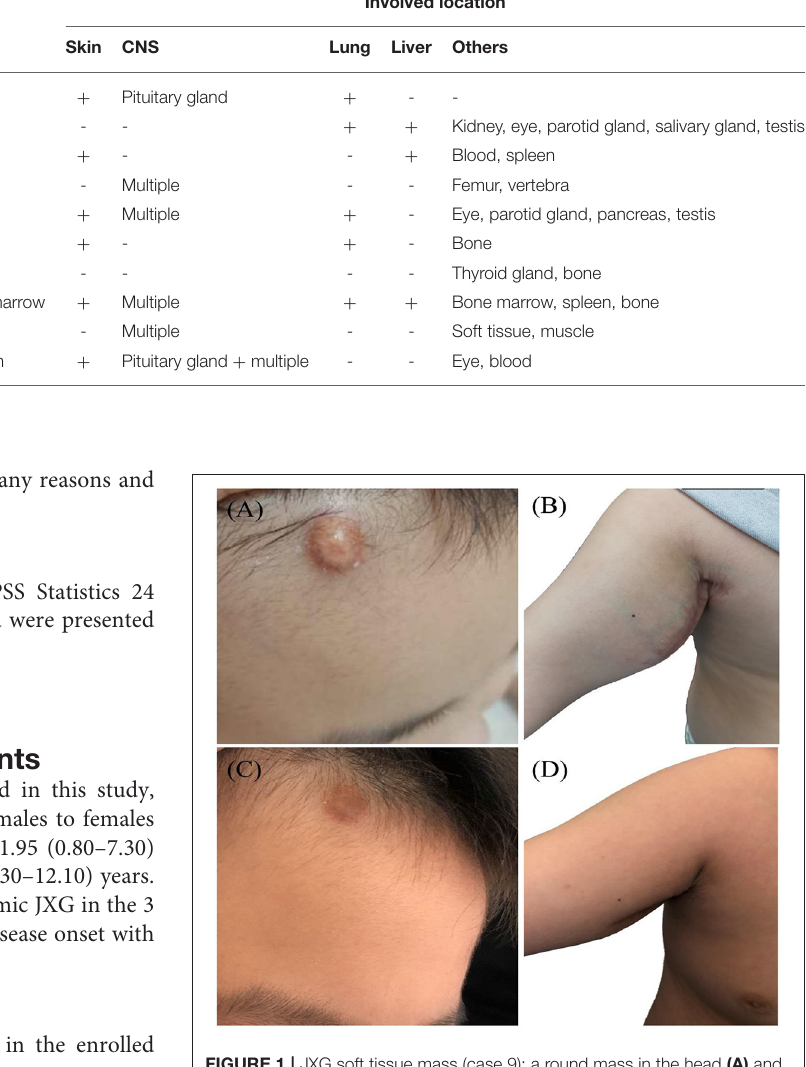
FIGURE 1 | JXG soft tissue mass (case 9): a round mass in the head (A) and right axilla (B) of the onset, tough, no tenderness. (C,D) Showed the mass after